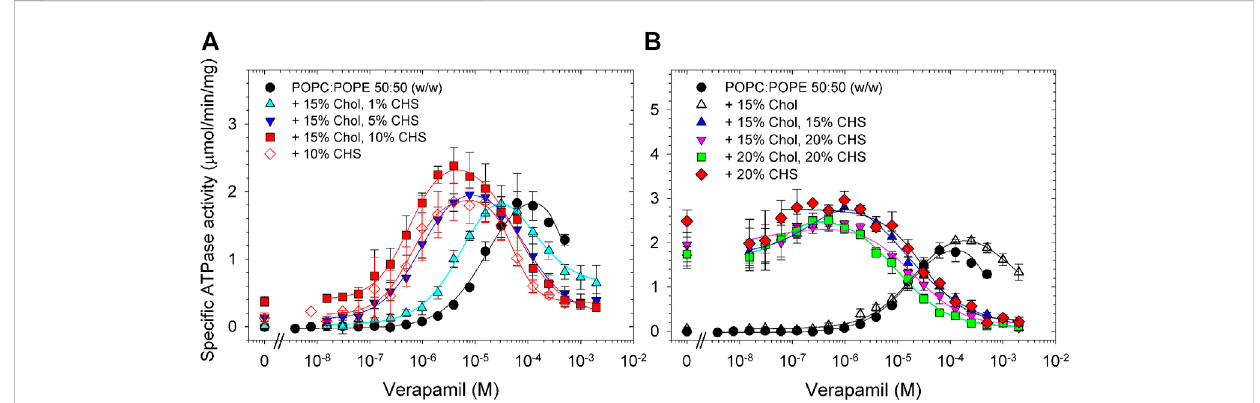
FIGURE 4 Effects on cholesterol and CHS on the verapamil-stimulation of ATPase. Puri fi ed Pgp was activated with 10 mM DTT and POPC:POPE (50:50, w/w) supplementedwiththeindicatedconcentrationsofcholesterolandCHS. (A) 1% – 10%CHS; (B) 15%or20%CHS.ATPaseactivitywasassayedasdescribed in Experimental Procedures. Data points represent the mean ± SEM ( n =